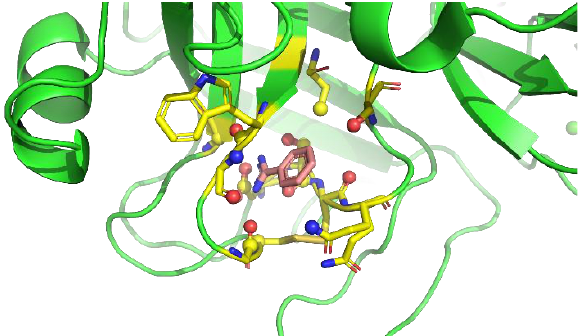
Figure 3. Definition of amino acid residues around the probe. Yellow residues are “amino acid residues around the probe”. Amino acid heavy atoms within 4 Å from any heavy atom of the probe molecule (red molecule) are shown as balls.